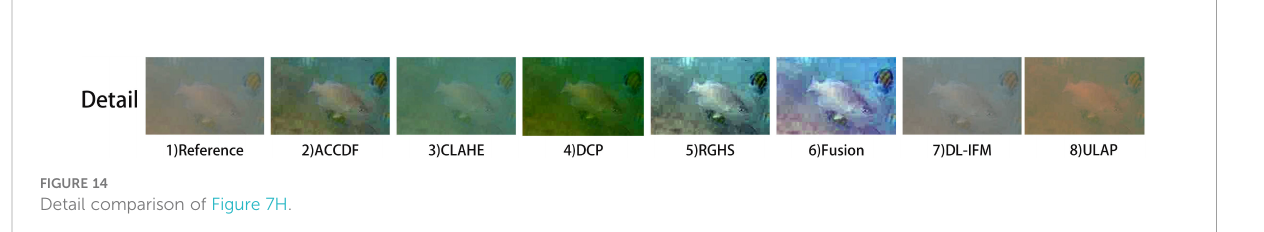
FIGURE 14 Detail comparison of Figure 7H.